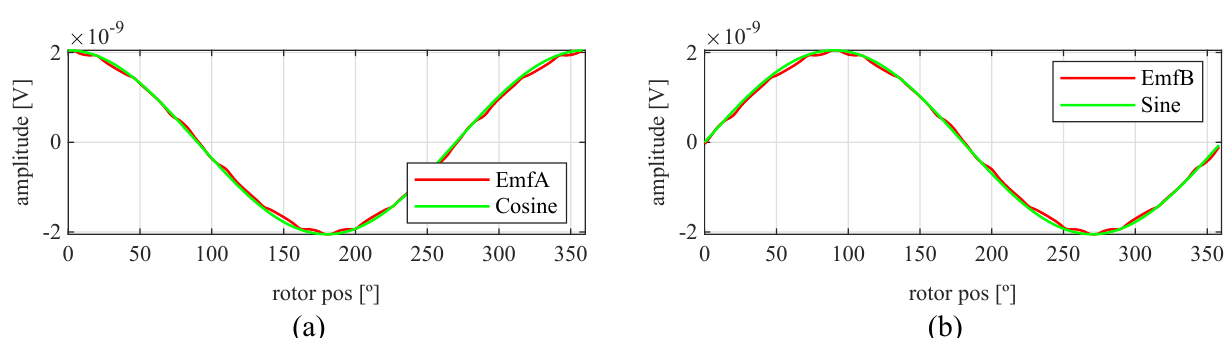
Figure 6. Full pitch four-slot resolver EMFs skewed for the least THD ( a ) before skew and ( b ) with skew. Observing Figure 6b, most of the existent harmonic content was eliminated, obtaining more sinusoidal resolver signals. These were compared with the ideal sine and cosine waves in Figure 7. Then, these signals were converted to position Figure 8, and finally the error was calculated Figure 9).